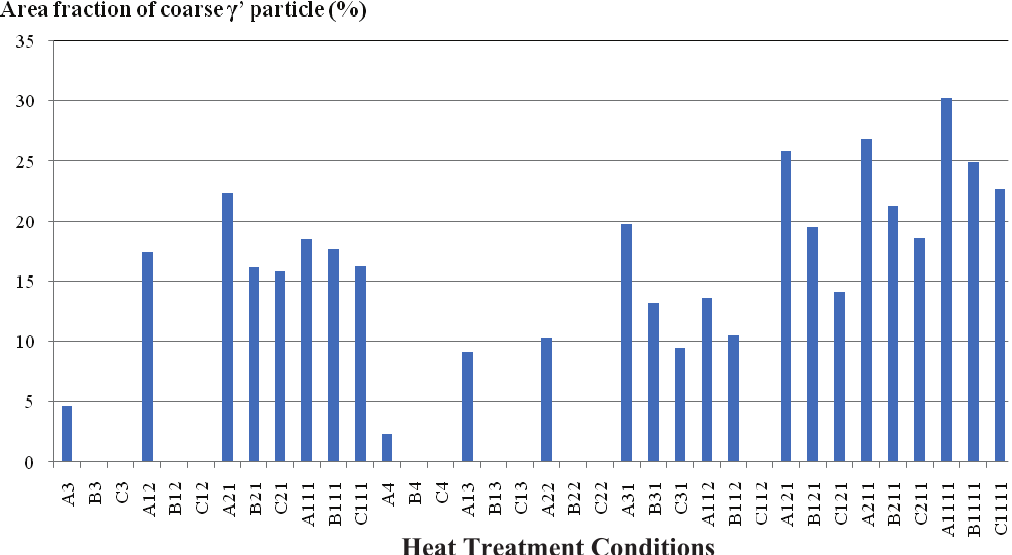
Figure 27. The relationship between heat treatment condition and area fraction of coarse (cid:2) 0 particles.